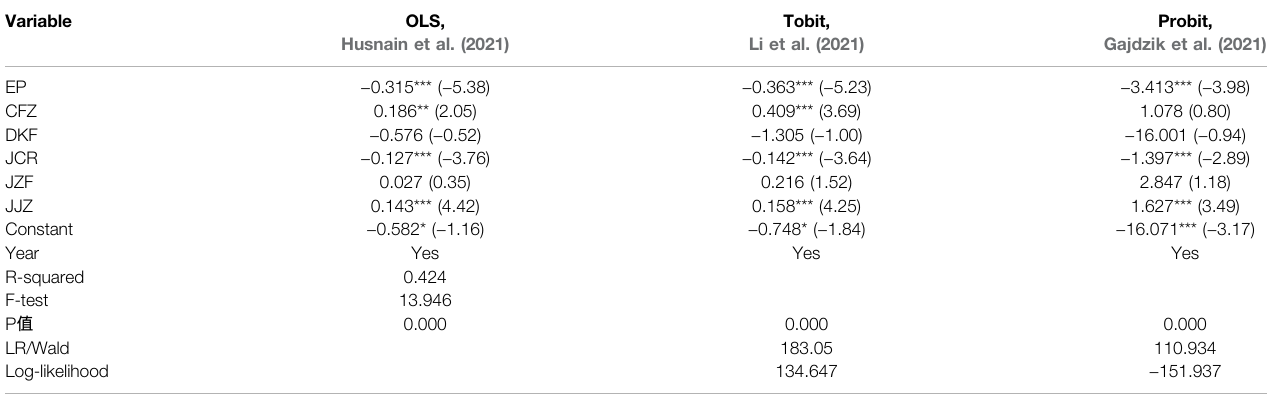
TABLE 5 | Main effect regression